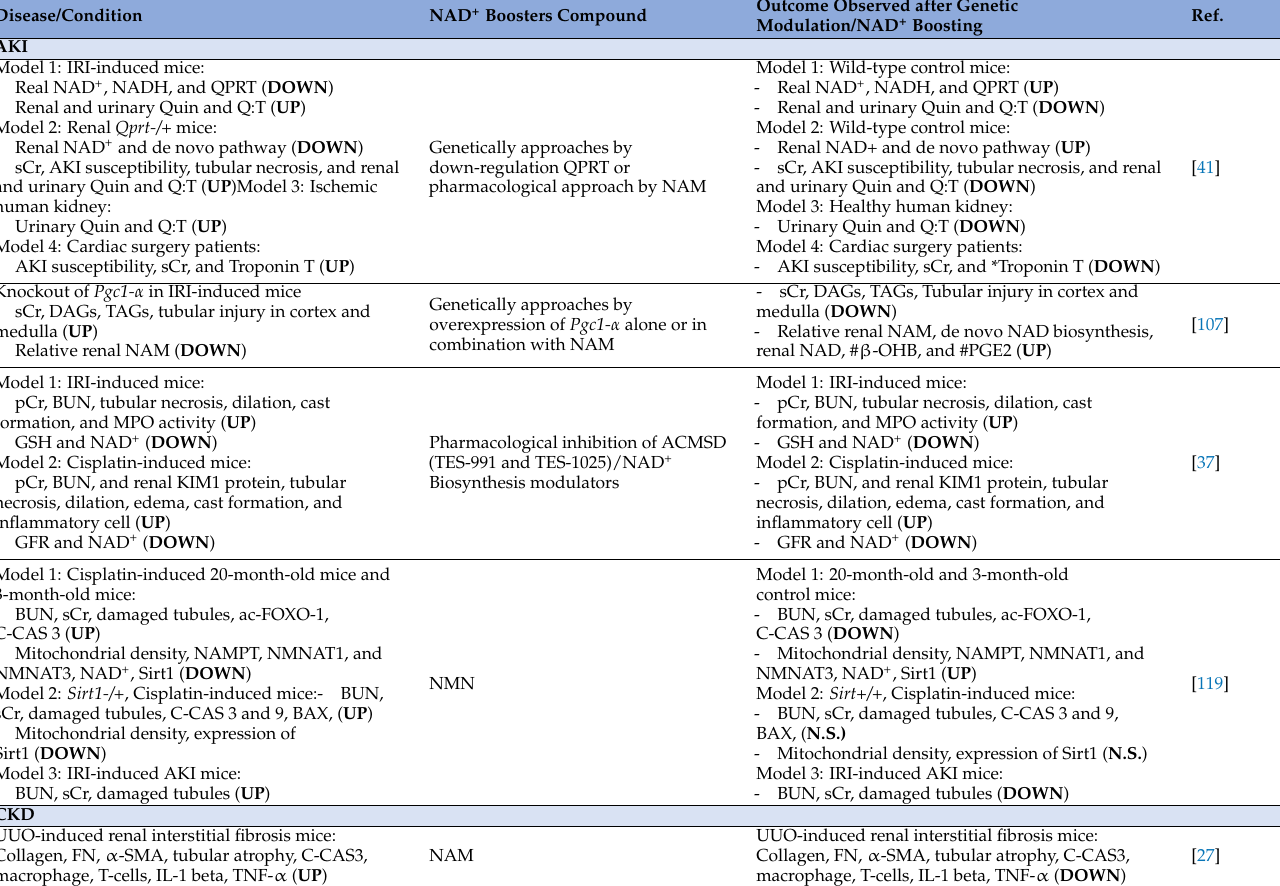
Table 1. NAD + -based therapies and their effects on some AKI and CKD studies. Disease/Condition NAD + Boosters Compound Outcome Observed after Genetic Modulation/NAD + Boosting